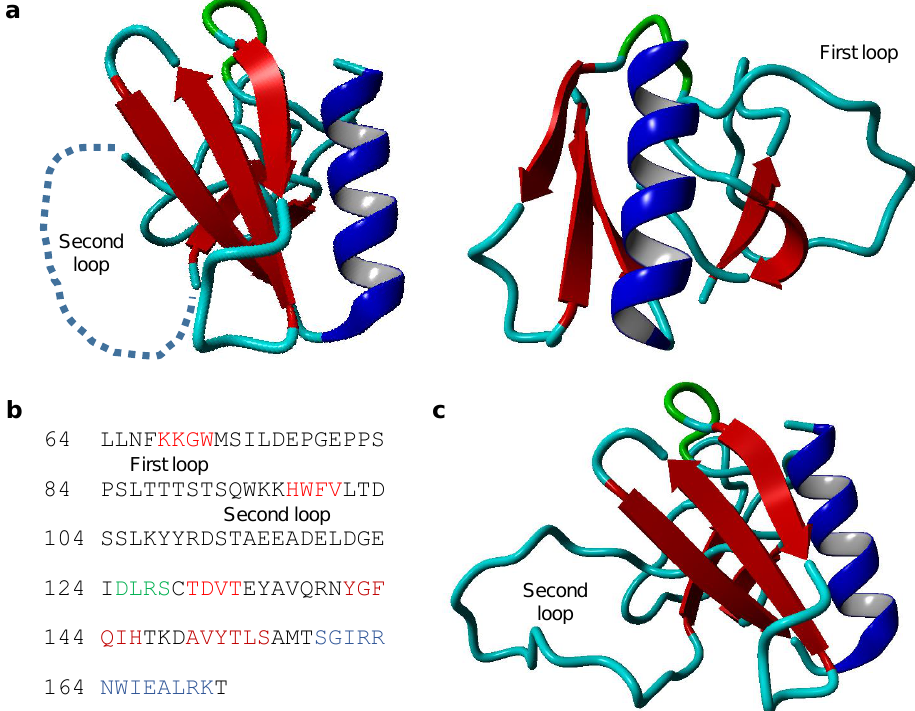
Figure 2. A structural homology model of the PH domain of TRIOBP-1 (amino acids 64–172 of 652 amino acid TRIOBP-1). ( a ) Images of the model, with the first loop region displayed. ( b ) Amino acid sequence of the PH domain, with the first and second loop regions indicated. Coloring corresponds to the secondary structures seen in the molecular images. ( c ) Image of the model including a low quality prediction of the strength of the second loop region. Model generated using MODELLER 9.20 [16], based principally on the structure of the PH domain of DAPP1 (PDB ID: 1FAO), which includes sequence analogous to the first loop region. Shorter sections including the second loop were modeled with additional templates (PDB ID: 2DYN, 2D9Y, 3GOC, and 5YUG). Alignments were generated using CLUSTAL Omega 1.2.4 [8], and then optimized manually. Of the 20 models generated, the one with the lowest objective function score was visualized using YASARA 18.4.24